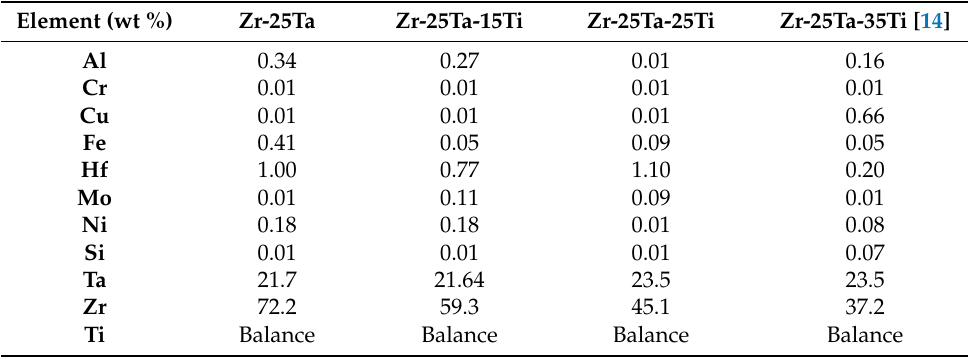
Table 1. Chemical analysis of the produced Zr-25Ta-xTi alloys using ICP-OES.